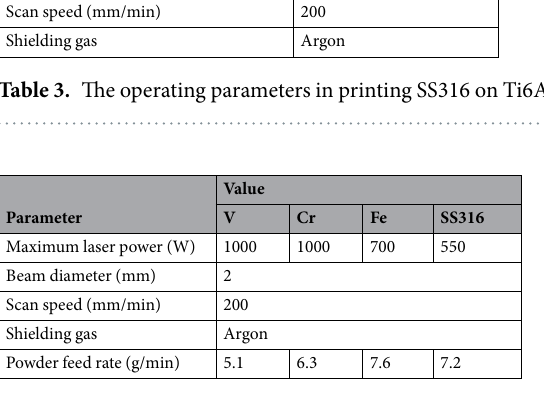
Table 4. The laser processing parameters in laser 3D printing.